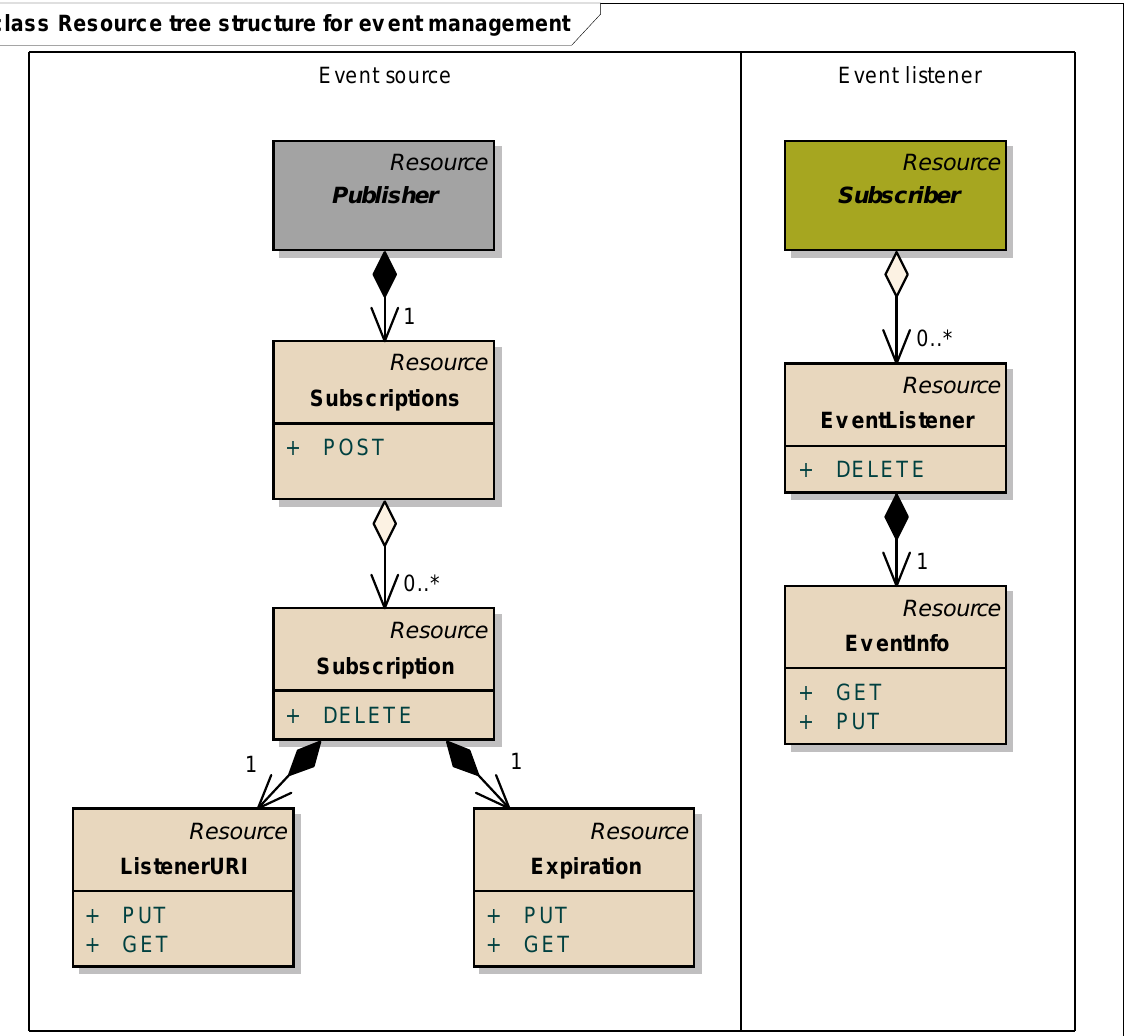
Figure 5. Resource model for event